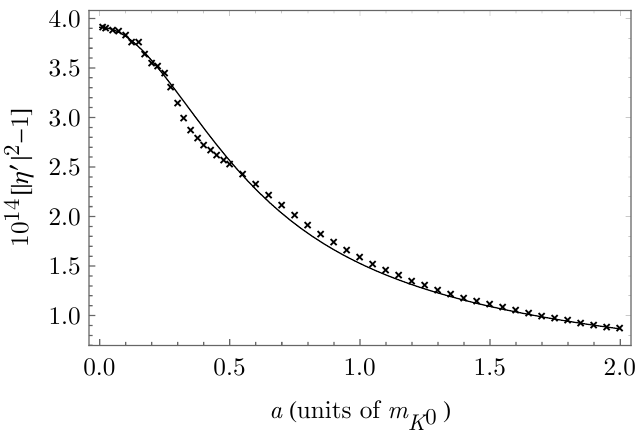
Figure 3 . Numerical results for | η 0 | 2 − 1 as a function of the acceleration a and plot of an approx- imation obtained from singular